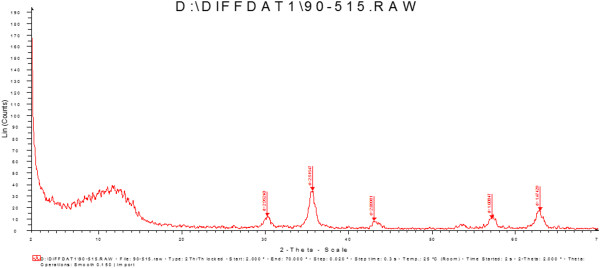
XRD patterns of (a) pure Fe3O4 nanoparticles.